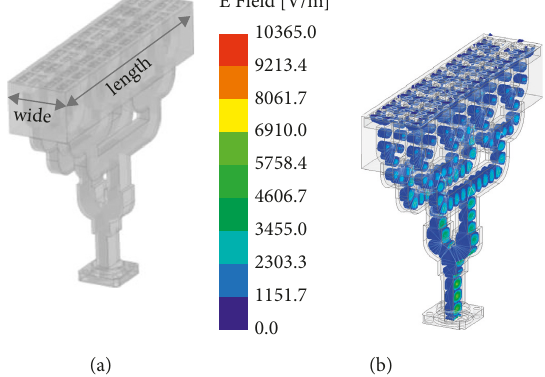
Figure 6: (a) Schematic and (b) electric field distribution of the 2